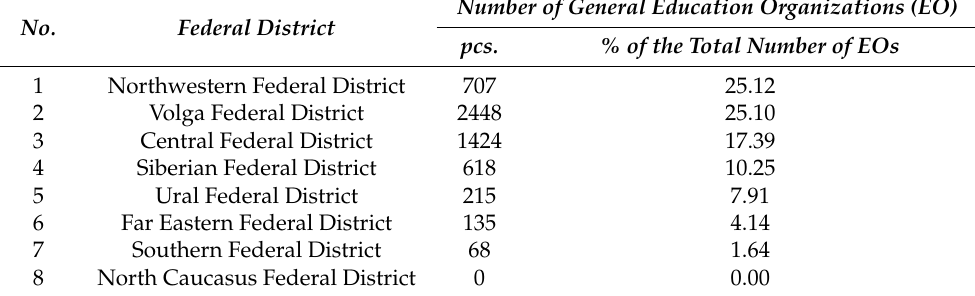
Table 2. The number of educational institutions using automated parental controls of school meals in federal districts of the Russian